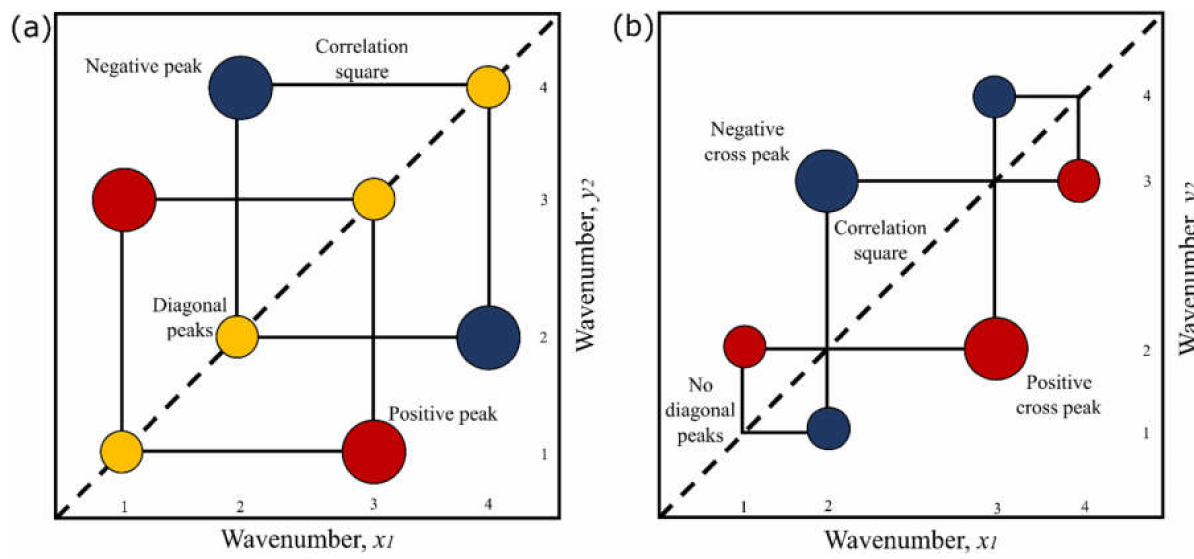
Figure 1. Schematic contour map of: ( a ) synchronous 2D-corr spectrum, ( b ) asynchronous 2D-corr spectrum. Auto-peaks located along the main diagonal. Peaks with a positive sign. Peaks with a negative